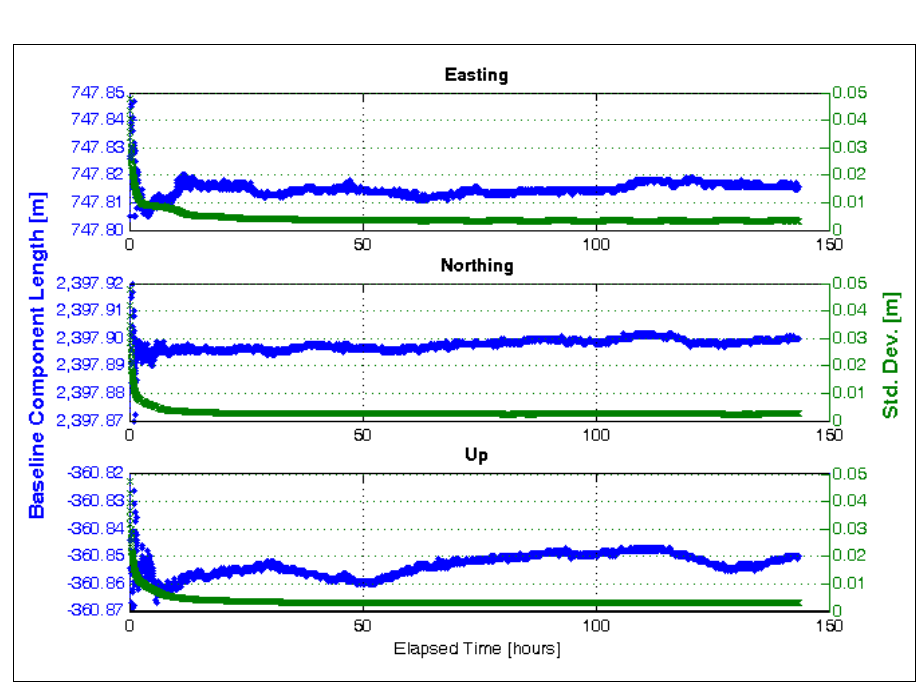
Figure 3 . Continuous, TD, east, north, up solutions using